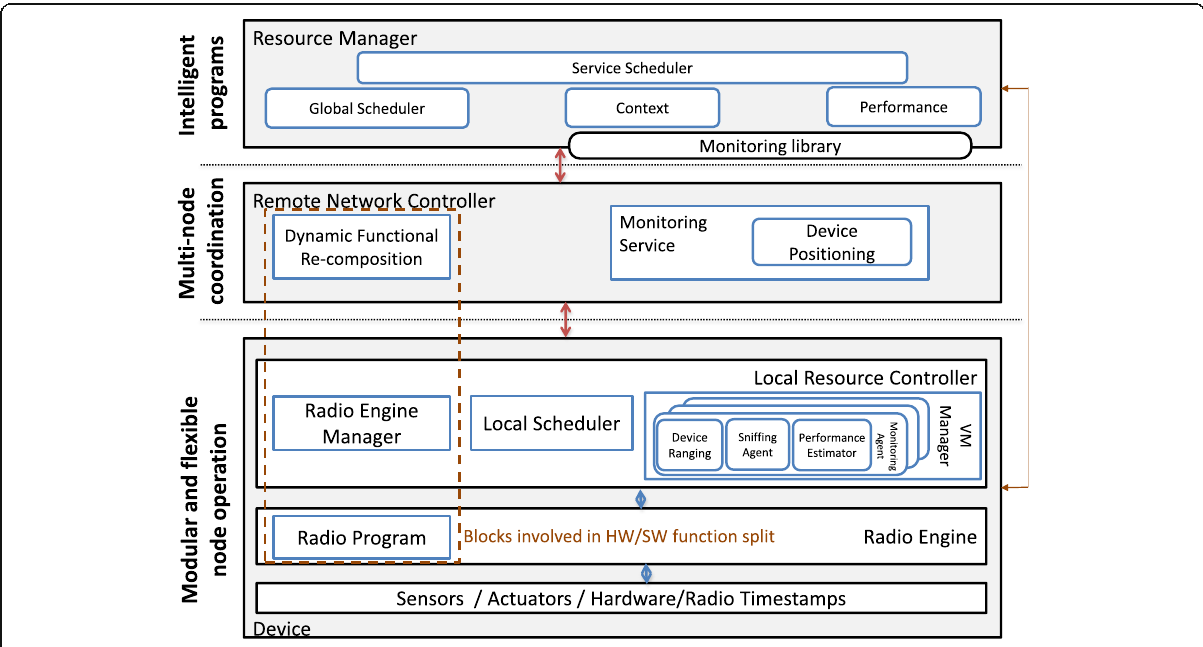
Fig. 2 Functional architecture for context and content-aware 5G